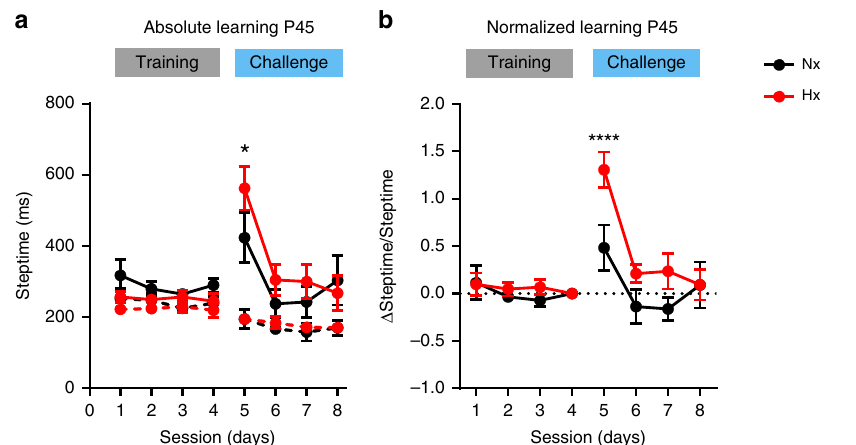
Fig. 4 Adaptive cerebellar learning de fi cits in P45 Hx mice. a Absolute learning in P45 mice measured as a function of post-perturbation steptimes in Nx (black, solid) and Hx (red, solid) mice. Pre-perturbation steptimes (dashed traces) represent internal controls for Nx (black) and Hx (red). Nx: n = 7 animals, Hx: n = 7 animals. Statistics: two-way RM-ANOVA, matching: stacked along sessions, session effect F (7,168) = 8.706, P < 0.0001, treatment effect F (3,24) = 7.502, P = 0.001, treatment × session effect F (21,168) = 4.766, P < 0.0001. b Normalized learning in P45 mice quanti fi ed by normalizing